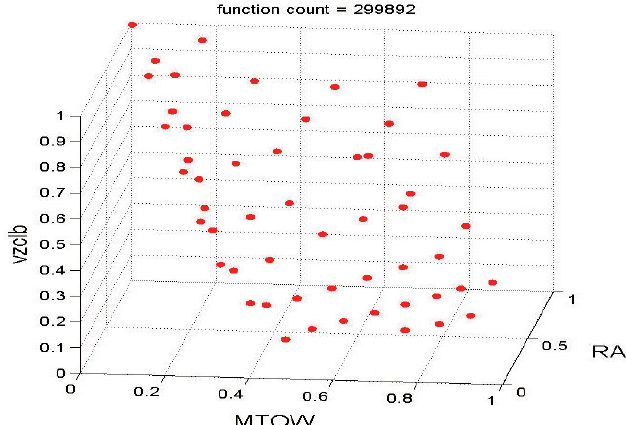
Fig. 11. Normalised Pareto